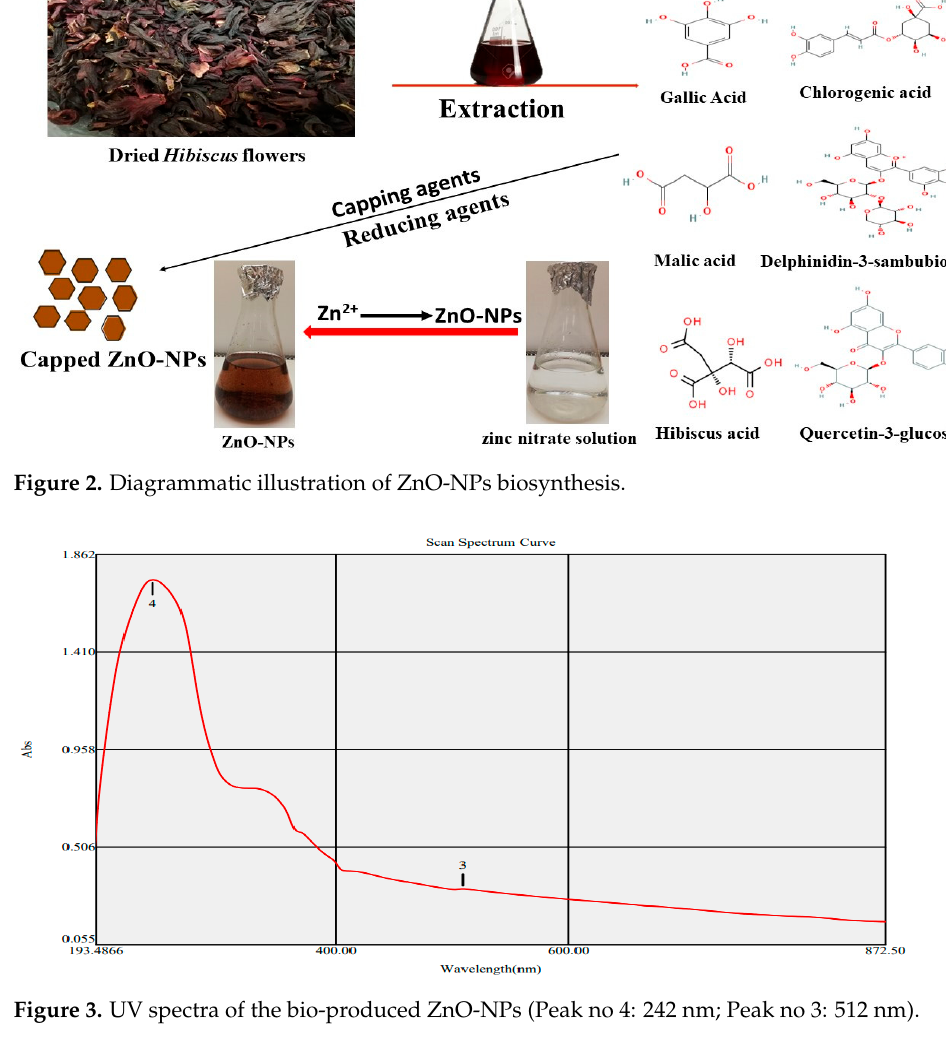
Figure 3. UV spectra of the bio-produced ZnO-NPs (Peak no 4: 242 nm; Peak no 3: 512 nm).